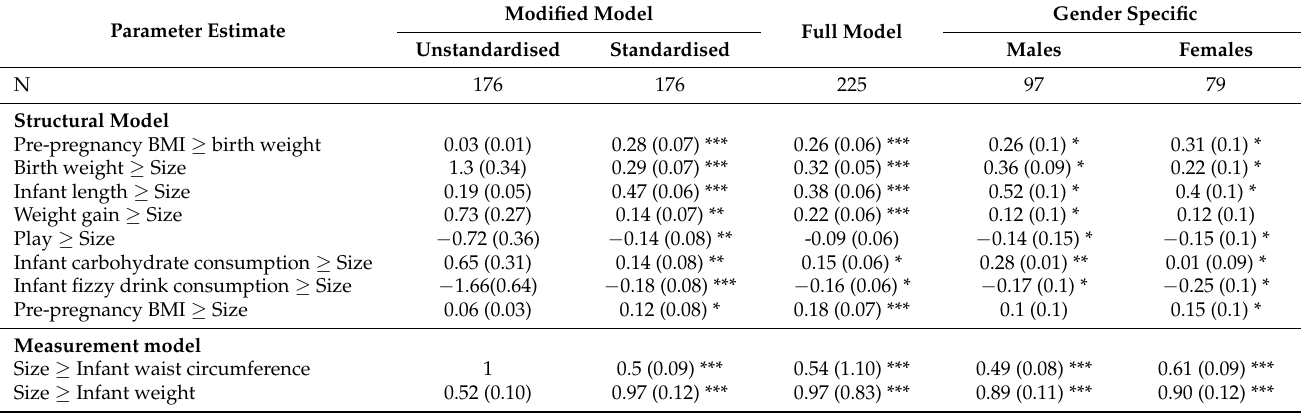
Table 2. Standardised estimates for the modified, full and gender-specific models.